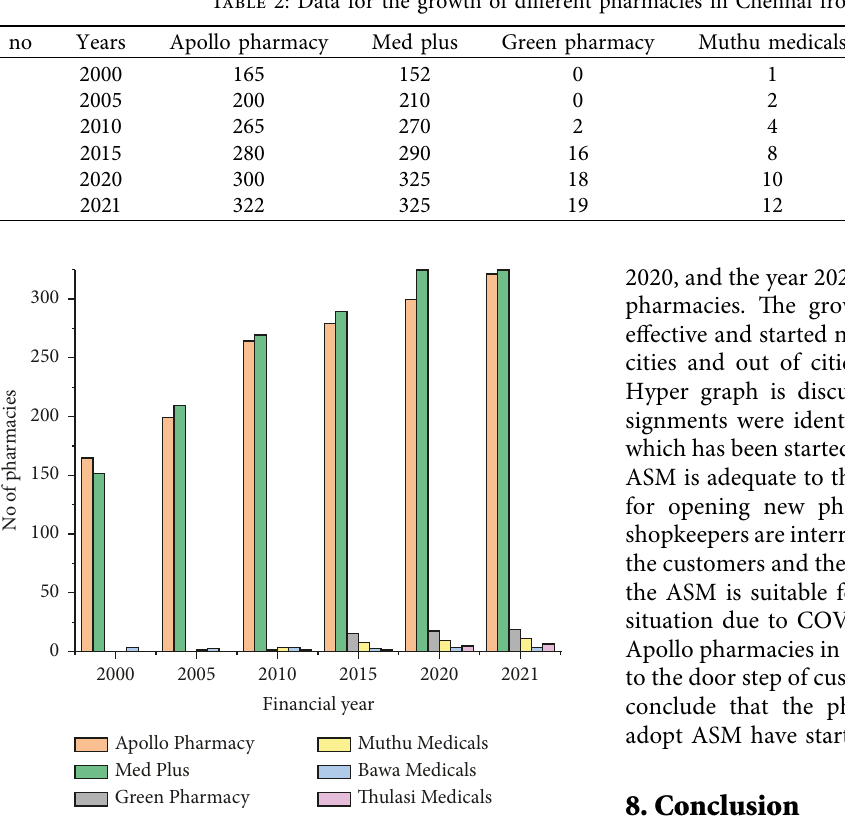
Figure 4: Trend line for the growth of pharmacies in Chennai.